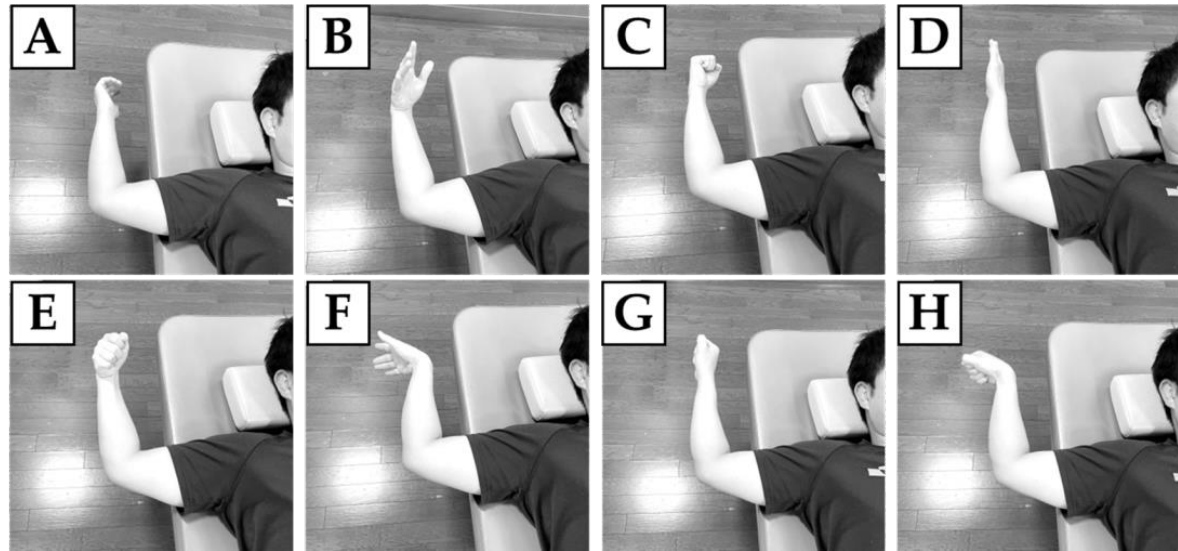
Figure 1. Muscle contraction tasks. ( A ) resting, ( B ) wrist ulnar flexion (contraction of FCU), ( C ) finger flexion (contraction of FDS), ( D ) forearm pronation (contraction of PT), ( E ) wrist ulnar flexion and finger flexion (contraction of FCU and FDS), ( F ) wrist ulnar flexion and forearm pronation (contraction of FCU and PT), ( G ) finger flexion and forearm pronation (contraction of FDS and PT), ( H ) wrist ulnar flexion, finger flexion, and forearm pronation (contraction of FCU, FDS, and PT). Each of the seven muscle contraction tasks (other than resting) was performed 3 times at maximum effort for 5 s. The order of these tasks was randomized.